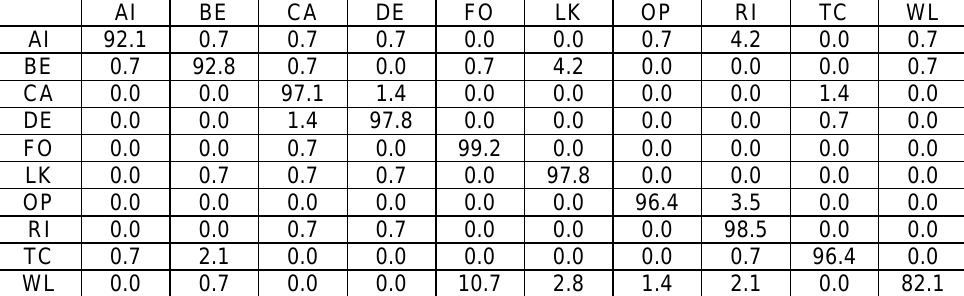
Table 6. Confusion Matrix for Optimized RSISC-16 Net Model in (%)